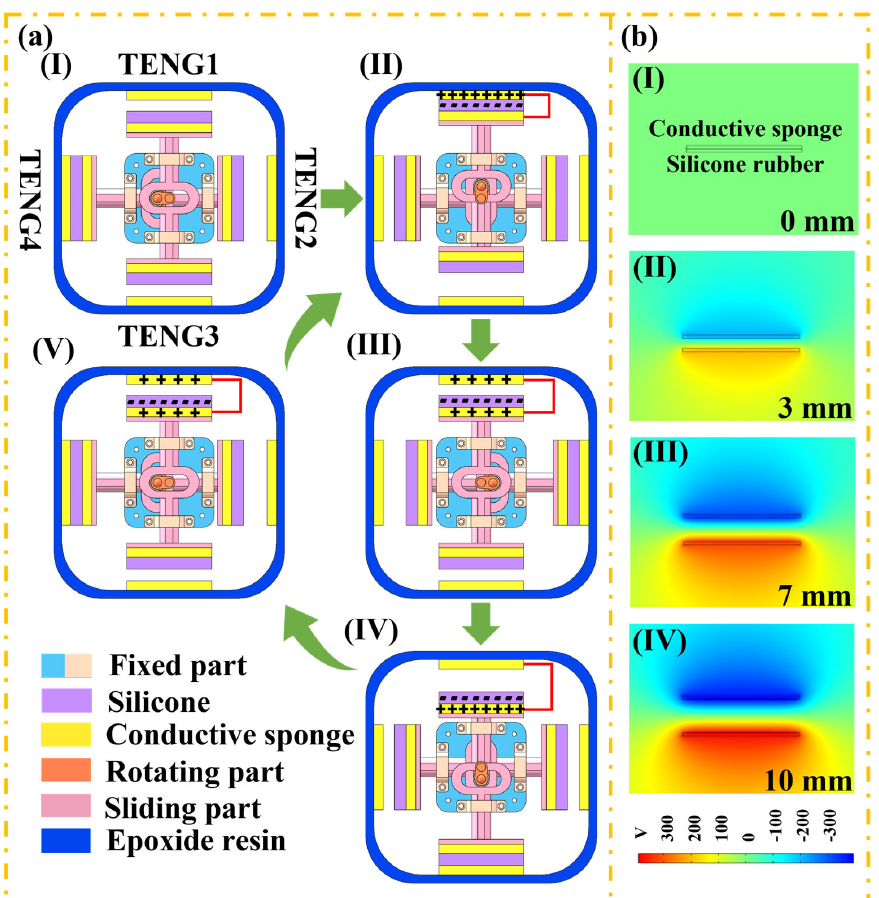
Figure 2. The working principle and simulation of the TENG: ( a ) working principle of the TENG; ( b ) simulation of the potential distribution of the TENG.